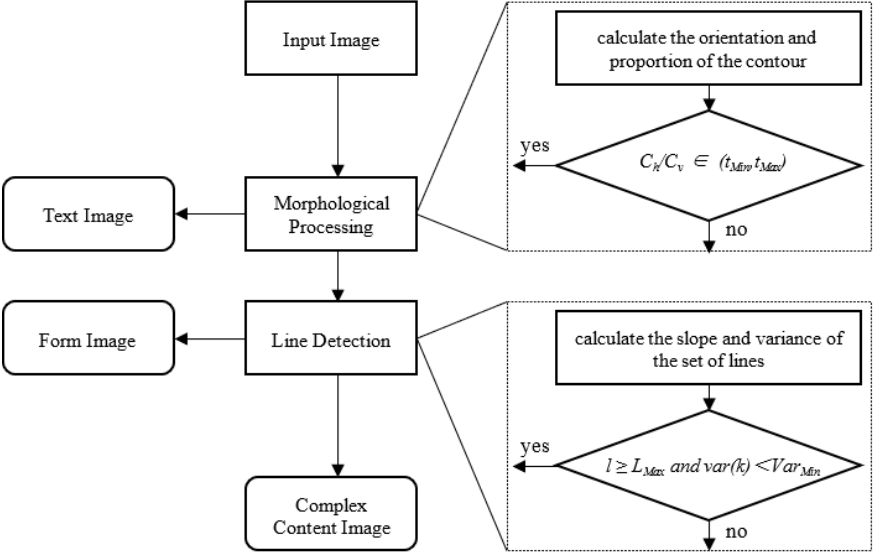
Figure 2. Working mechanism of Image classification.